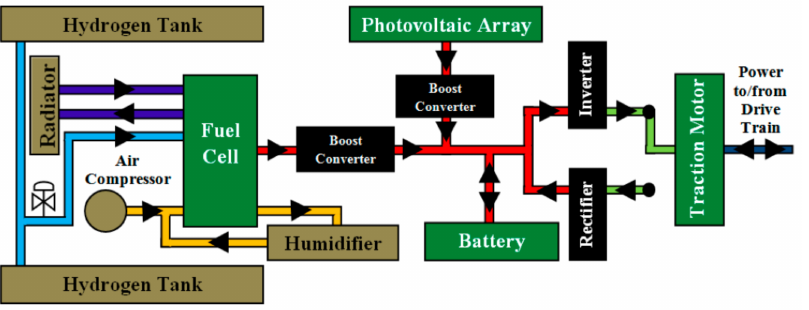
Figure 2. Schematic diagram of IPVFC system as power source for automotive applications